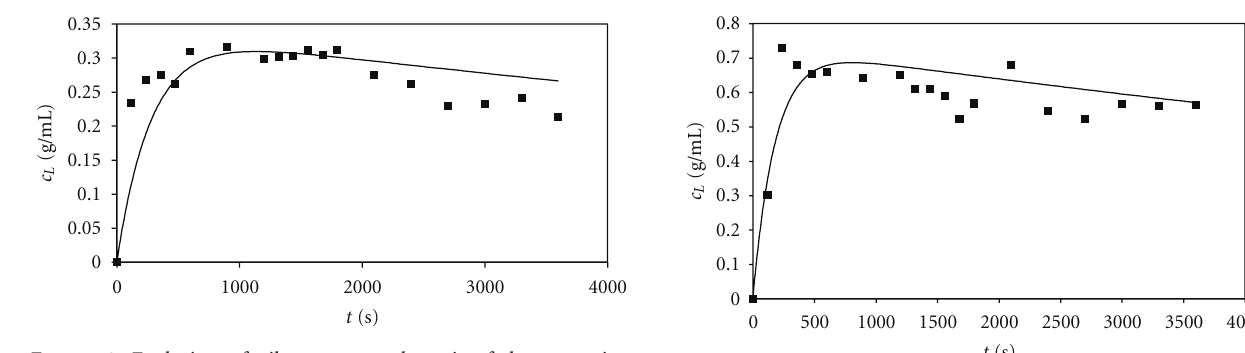
Figure 2: Evolution of oil content at the exit of the extraction column for collets.